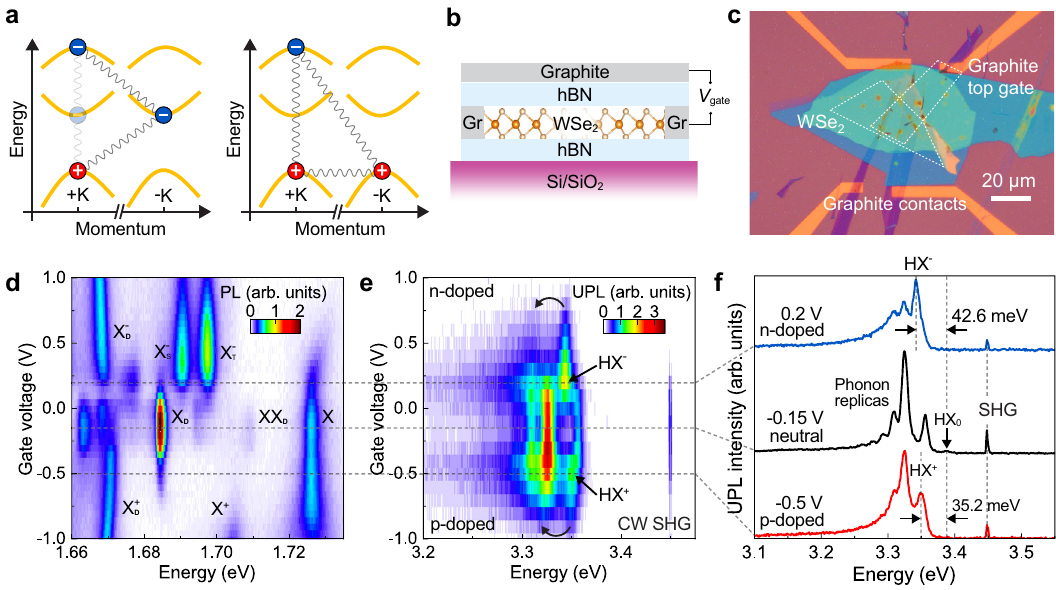
Fig. 1 | High-lying trions in monolayer WSe 2 . a Illustration of negatively and positively chargedhigh-lying excitons (HX),composedof anelectron from a high- lying conduction band with negative effective mass, a hole from the fi rst valence band, and an additional charge from a band-edge state. The semi-transparent electron and curved lines on the left illustrate an alternative structure of the negativelychargedHX,wheretheelectronsareindifferentvalleys. b , c Schematics and microscope photograph of the transistor device. The WSe 2 monolayer is encapsulated between thin hBN layers and connected to pre-pattern gold